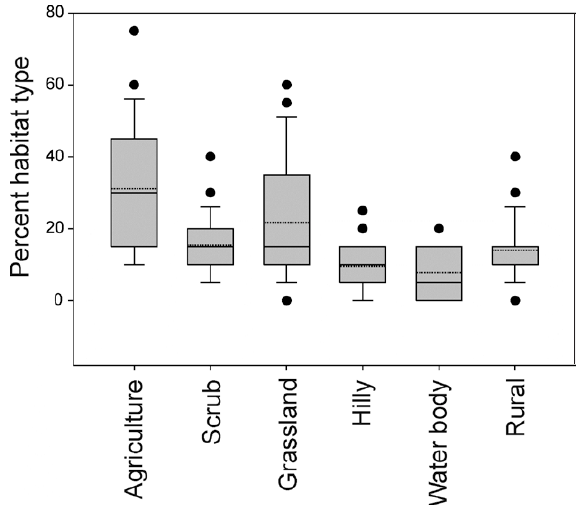
Figure 1. Percentage habitat type of breeding sites of Indian Eagle Owl. Agriculture is a dominant habitat followed by grassland and scrub habitats. Solid line inside the box denotes median and dashed line the mean.